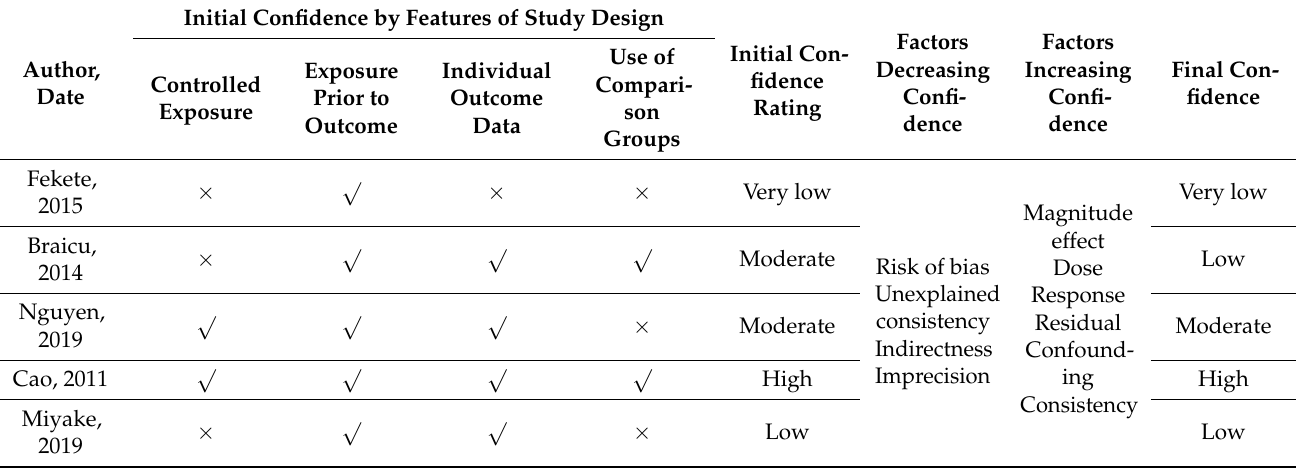
Table 4. Accessing confidence in body of evidence in selected